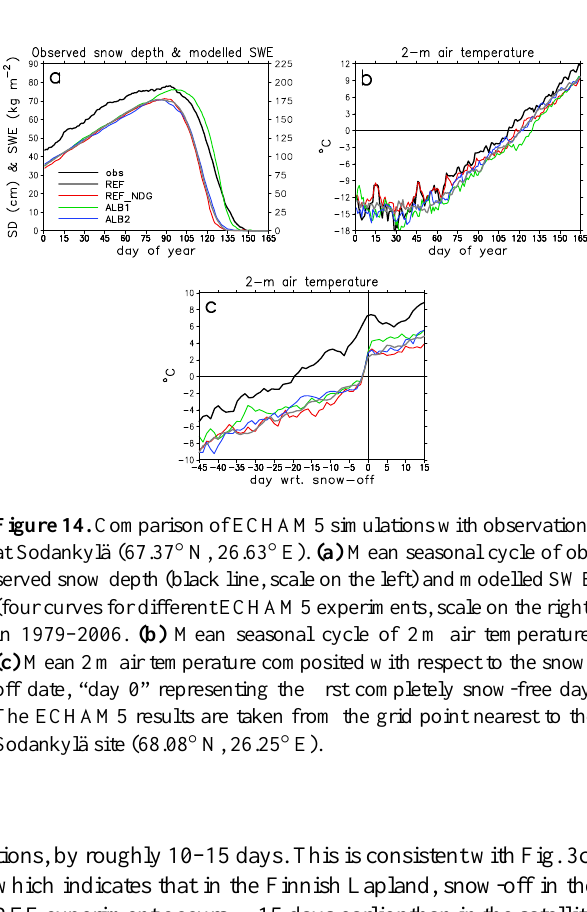
Figure 13. Differences in April–May mean albedo between ECHAM5 and the CLARA-SAL data set for the (a) REF, (b) REF_NDG, (c) ALB2 and (d) ALB2_NDG experiments. In ALB1 and ALB1_NDG (not shown) the albedo values are, by construction, identical to the CLARA-SAL data.